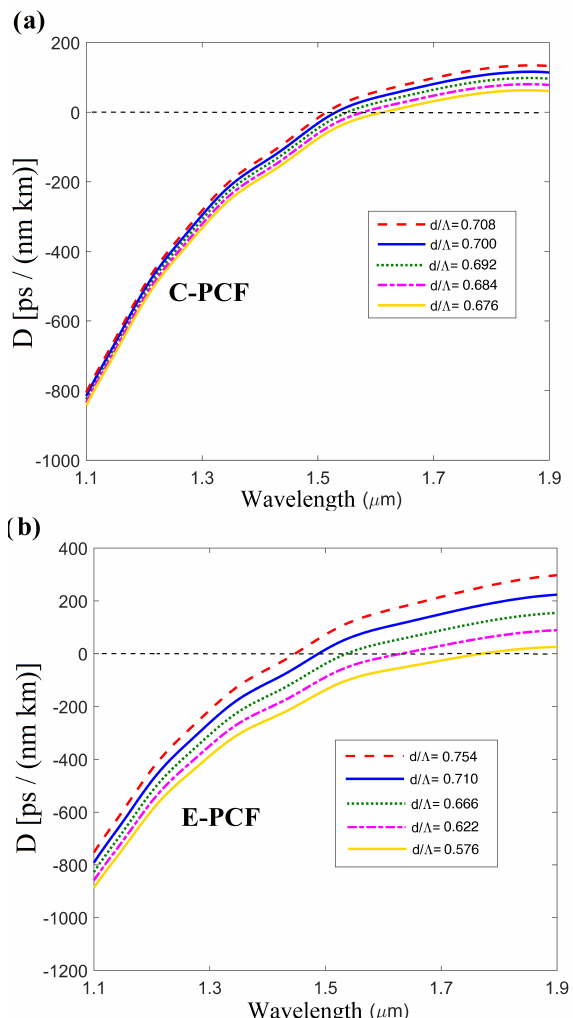
Figure 4. Dispersion of ( a ) C-PCF and ( b ) E-PCF with different air-hole dimensions as a function excitation wavelength. The C-PCF parameters are: d c / Λ = 0.876, Λ = 0.867, and E-PCF parameters are b / a = 0.79 and a = 1 µ